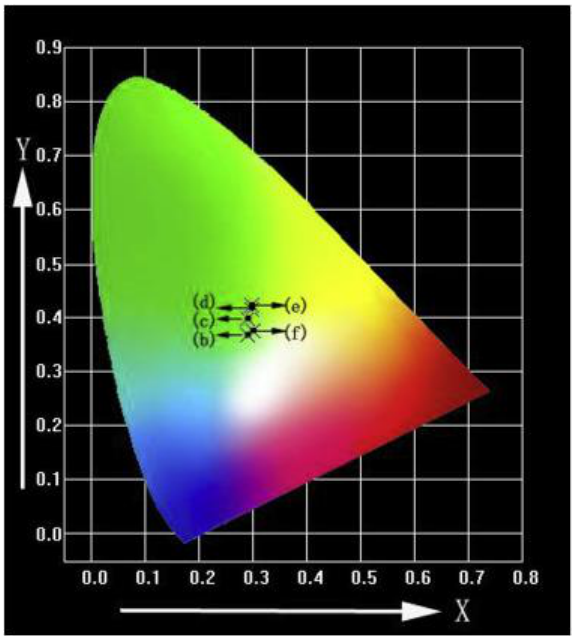
Figure 9. CIE (Commission International del’Eclairage) chromaticity diagram of 6 mol % Tb-HA determined by the corresponding emission spectra under excitation at λ ex = 378 nm [61]. Table 2. Commission International del’Eclairage (CIE) coordinates of 6 mol % Tb-HA [61]. Samples